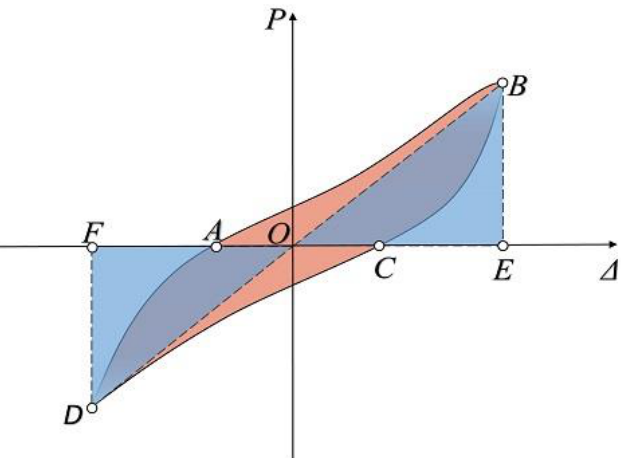
Figure 11. The dissipation capacity area.